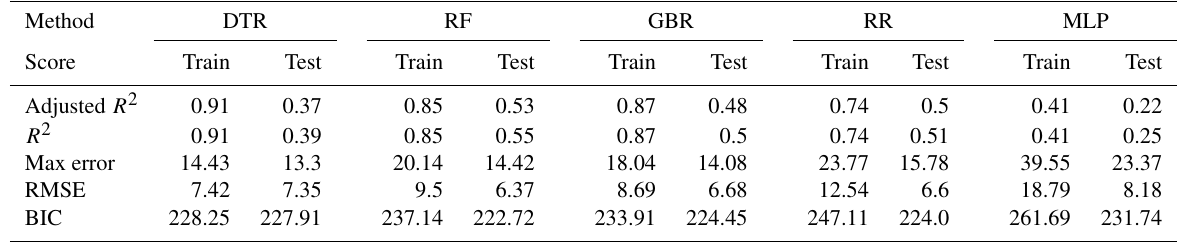
Table A6. Training and test scores on annual basis for the smoker population. Method